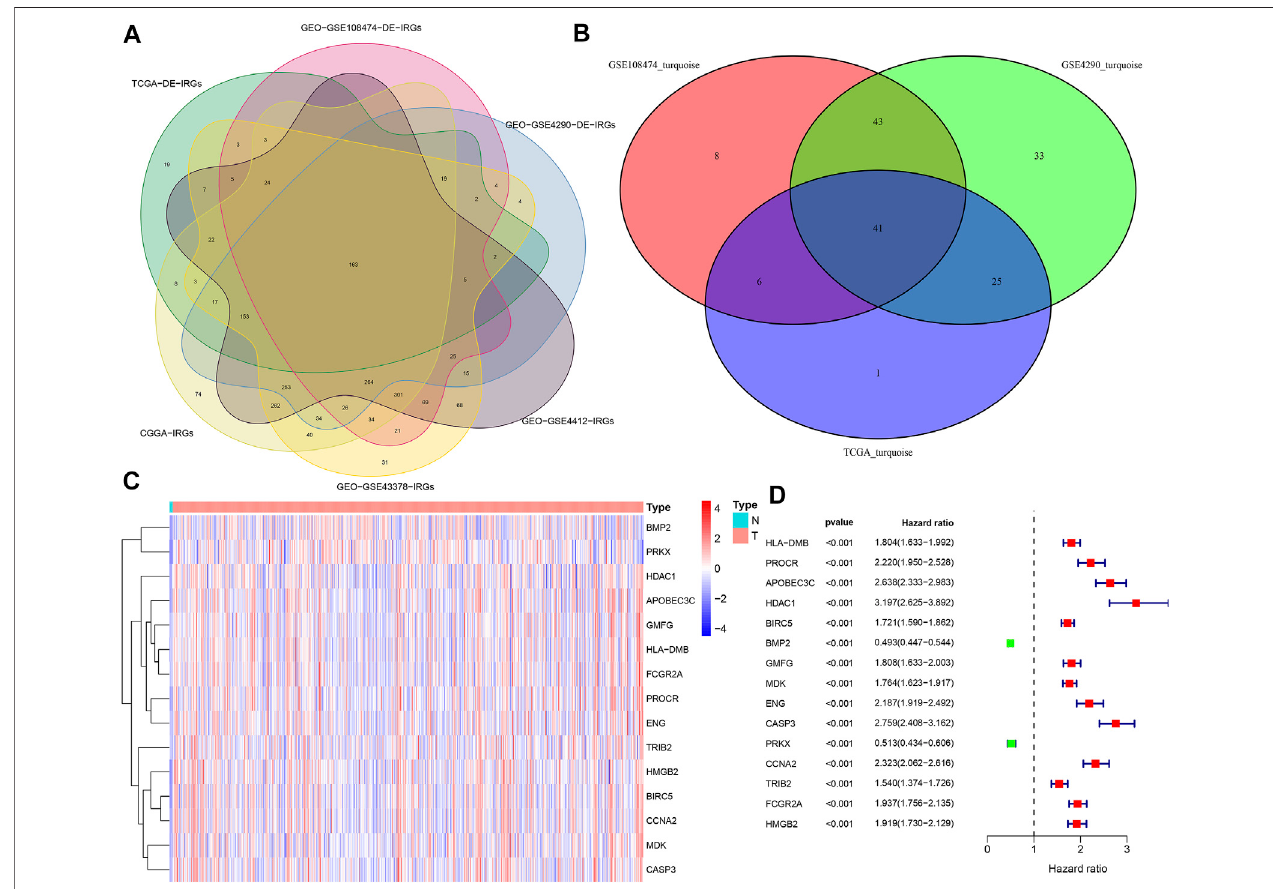
FIGURE2| ExtractionofPR-DE-IRGs. (A) VenndiagramshowingtheoverlappingprocessofDE-IRGslistsfromthreesetsandIRGslistsfromthreeothersets. (B) Venn diagram showing the overlapping process of genes from TCGA turquoise module, GSE4290 turquoise module and GSE108474 turquoise module. (C) Heatmap re fl ecting the expression levels of 15 PR-DE-IRGs in TCGA samples. (D) Forest plot showing the univariate Cox regression analysis results of 15 PR-DE-IRGs in TCGA.